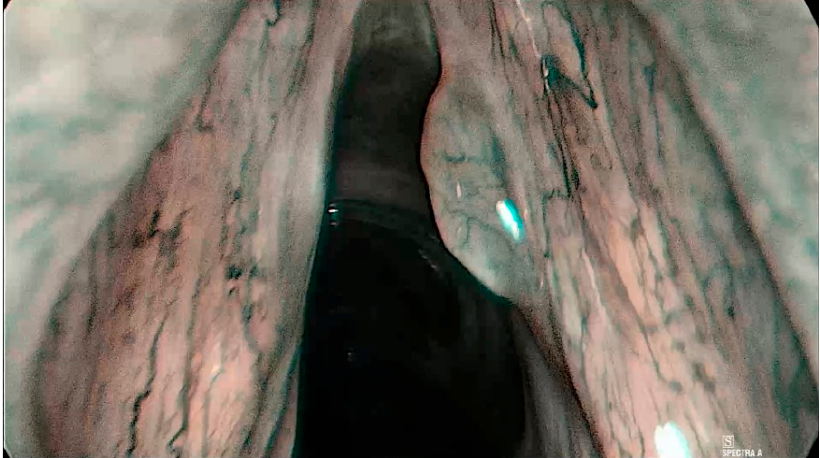
Figure 2. Histologically verified polyp of the right vocal cord, Ni type II of the mucosal vasculariza- tion, ELS classification—longitudinal type of vascularization.